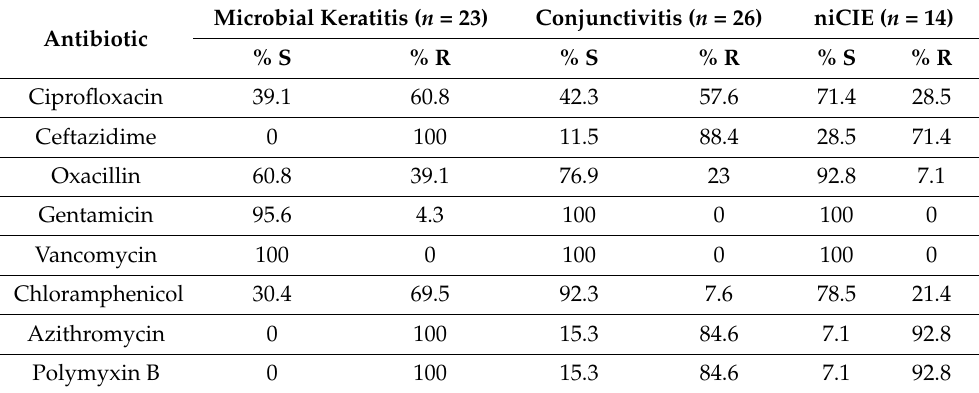
Table 1. Percentage of sensitivity and resistance of S. aureus strains from different ocular conditions to